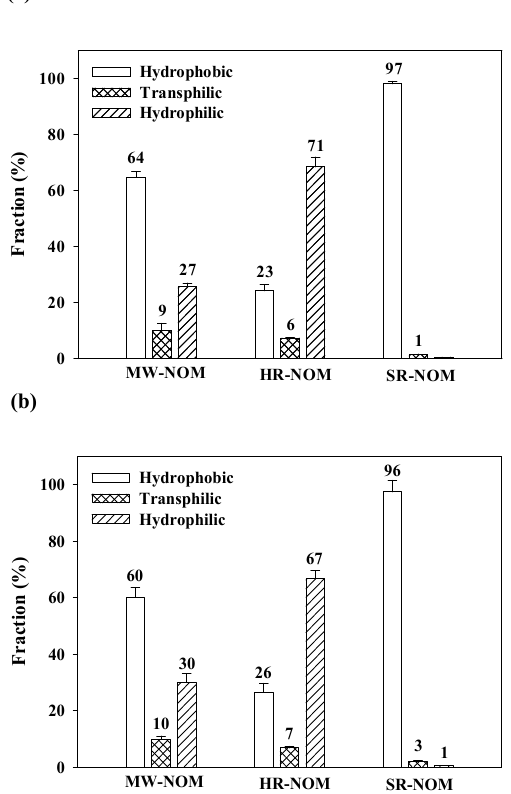
Figure 6. Relative polarity of various types of natural organic matter determined by XAD ( a ) with columns and ( b ) with SPE cartridges.